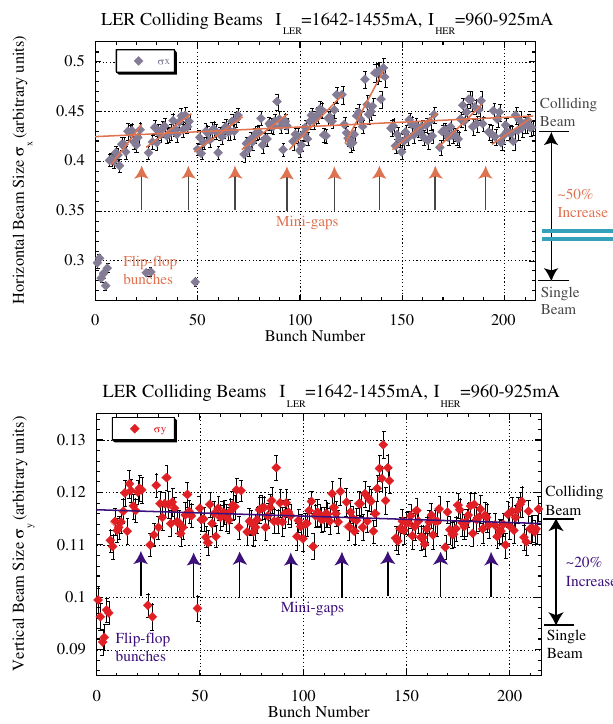
FIG. 18. (Color) Horizontal and vertical beam size as a function of bunch number with colliding beams at the PEP-II LER in 2001 [104]; the measurement was taken by a gated camera, with an LER bunch current of 2.0 mA (HER bunch current 1.25 mA); short 22-bunch trains were separated by minigaps of two missing bunches; the bunch spacing was four rf